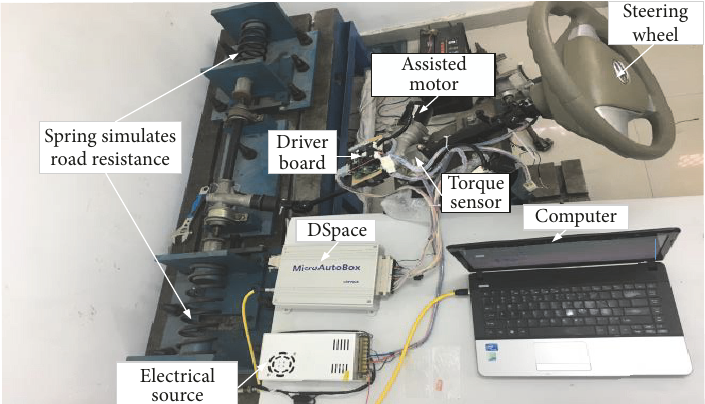
Figure 8: EPS system test bench.